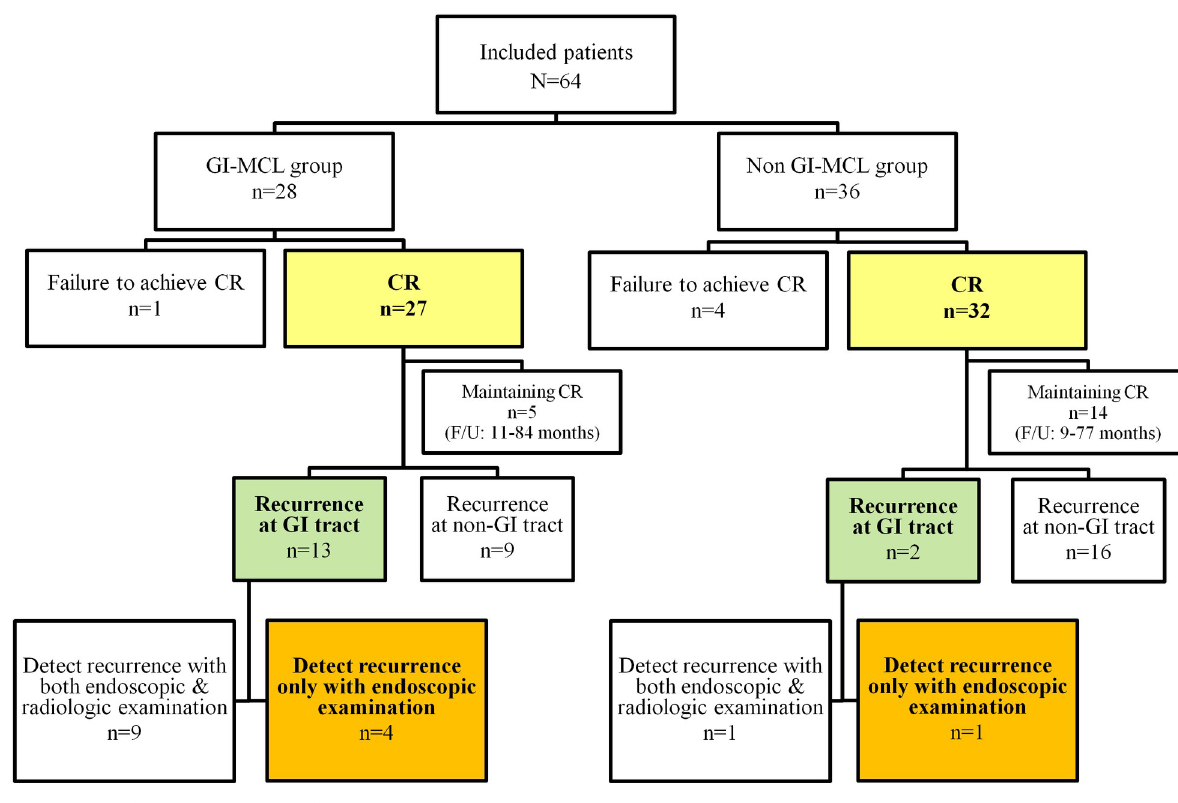
Fig 3. Status of recurrence in the included